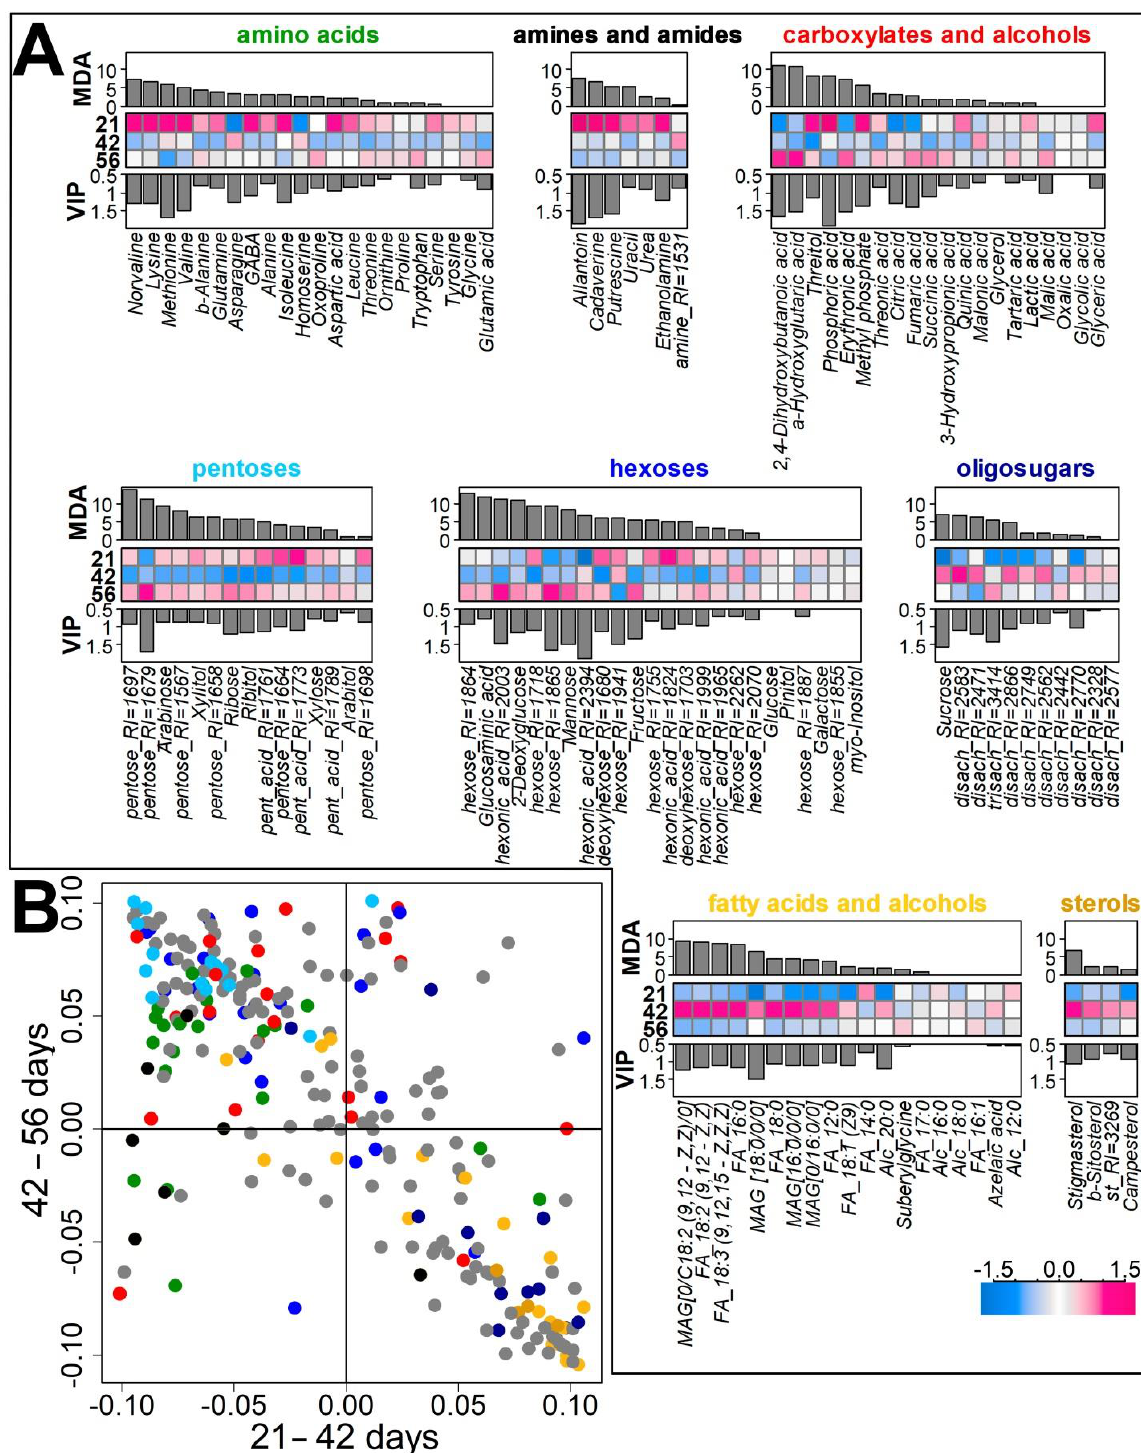
Figure 3. Analysis of age dependence of metabolite profile diversity. ( A ) Heatmaps of arbitrary normalized metabolite levels in pea cv. Finale roots during development of control plants sampled at days 21, 42, and 56. The top barplots are Mean Decrease Accuracy (MDA) obtained by the Random Forest, the bottom barplots are VIPs from PLS-DA. ( B ) SUS-plot: metabolite scattering in the space of loadings from OPLS-DA models for comparing roots of 21 and 42 day old plants (abscissa) and 42 and 56 day old (ordinate); positive values correspond to higher level at a later stage. Colors mirror chemical classes. Grey circles correspond to unidentified metabolites. “MAG”—monoacylglycerol; “FA”—fatty acid; “Alc”—fatty alcohol; “st”—sterol; RI—Kovatc retention index.